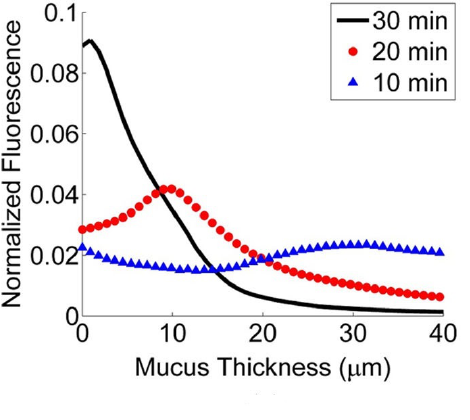
Figure 4. Vertical distribution of poly(lactic-co-glycolic) acid-dexamethasone FITC BaFe 12 O 19 nanoparticle (PLGA-Dex-FITC-BaNp) aggregates in mucus at specific times. Magnetic force, gravity, and diffusion effects acted on MNPs in the vertical z direction. Position z = 0 represents the bottom of mucus layer, and MNPs were pulled towards z = 0 over time. Distributions were mapped at 10, 20, and 30 min after releasing MNPs. This figure is taken directly from Ref. [17]. Reproduced with permission from Economou, E.C, BioNanoScience; published by Springer Nature, 2016. The speed at which this maximum moves is taken as the terminal velocity in mucus.